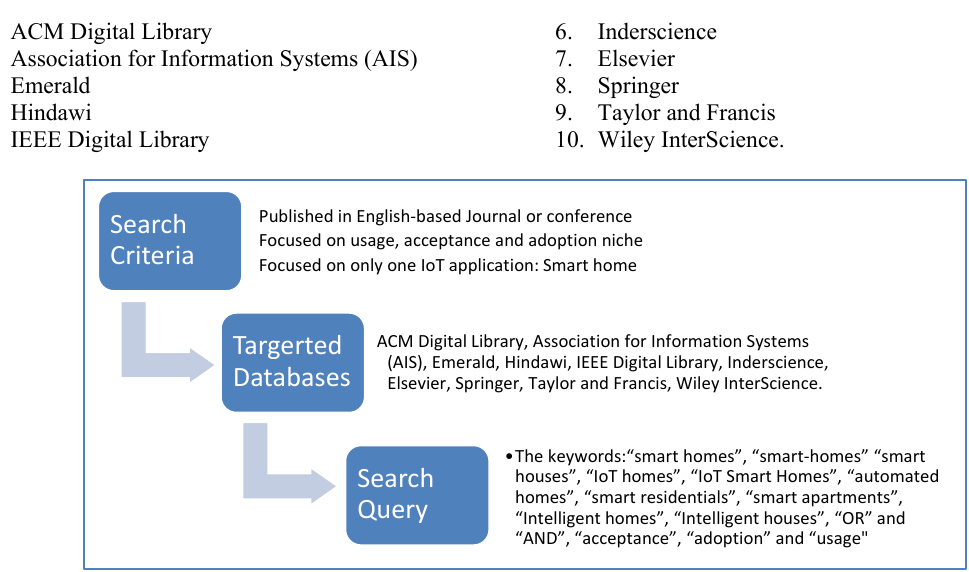
Fig. 2. Flowchart of Survey criteria, targeted databases and search